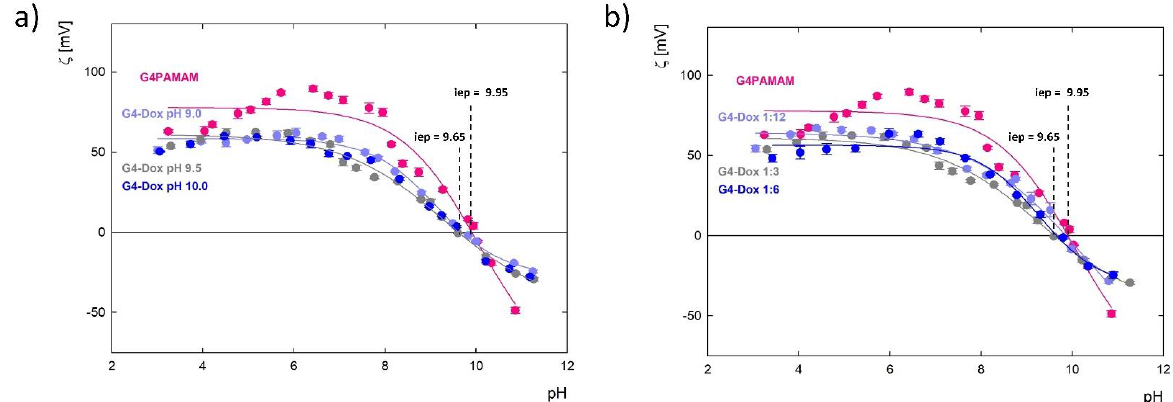
Figure 9. Change in the zeta potential (ζ) of the G4 .0 PAMAM dendrimer and complexes with doxorubicin: ( a ) depending on the pH of formation and ( b ) the molar ratio of the components at pH 9.5. Table 4. Effective charge ( N c ), degree of ionization ( α ), and a number of ionized surface groups (n NH3+ ) for an aqueous solution of G4PAMAM dendrimer as a function of pH.